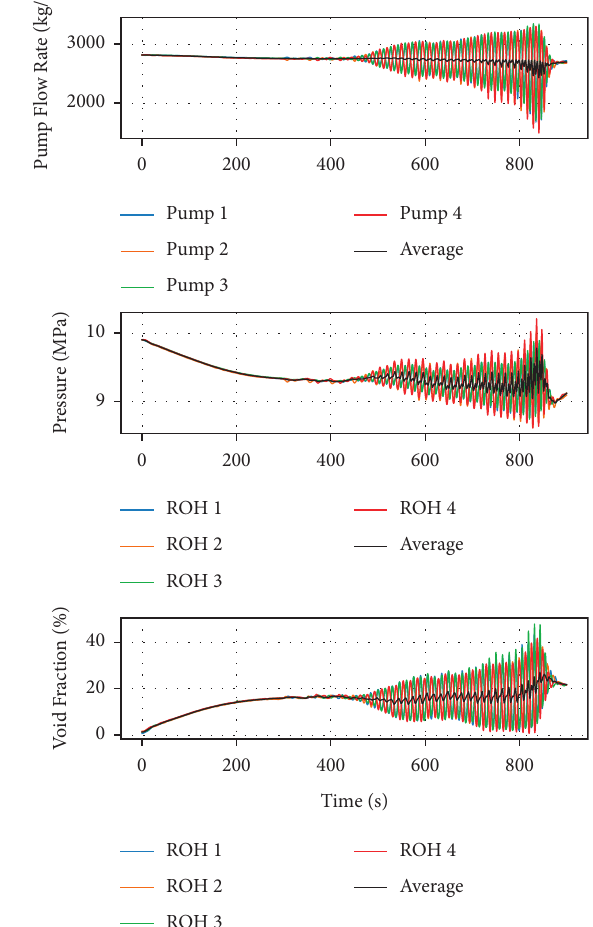
Figure 26: Flow oscillations at 108% full power, with balance headers unblocked after 200 seconds. The even pair of pumps and headers oscillate out-of-phase with the odd